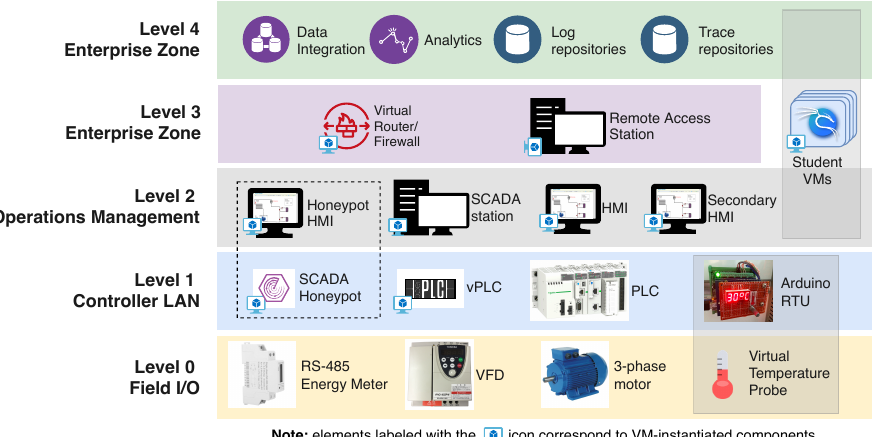
Figure 5. Cyber range environment (green VMs used for students; yellow VMs support services and testbed components for the specific